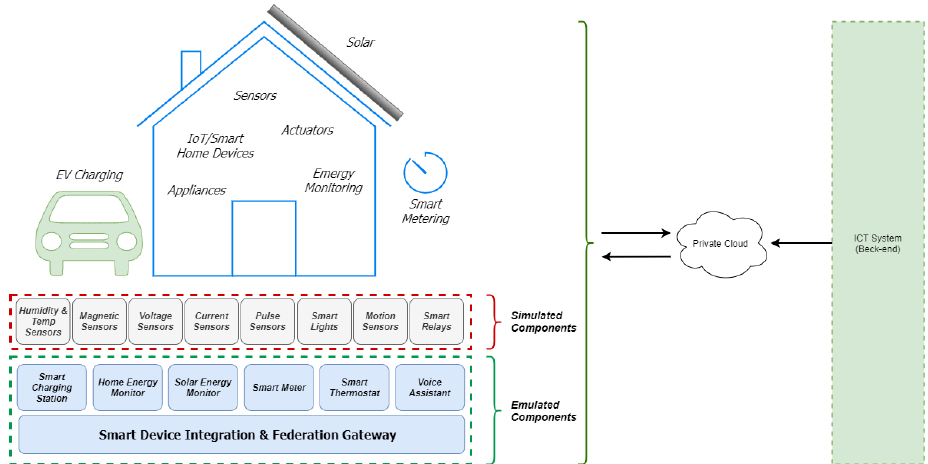
Figure 6. IoT-enabled smart home training scenario.